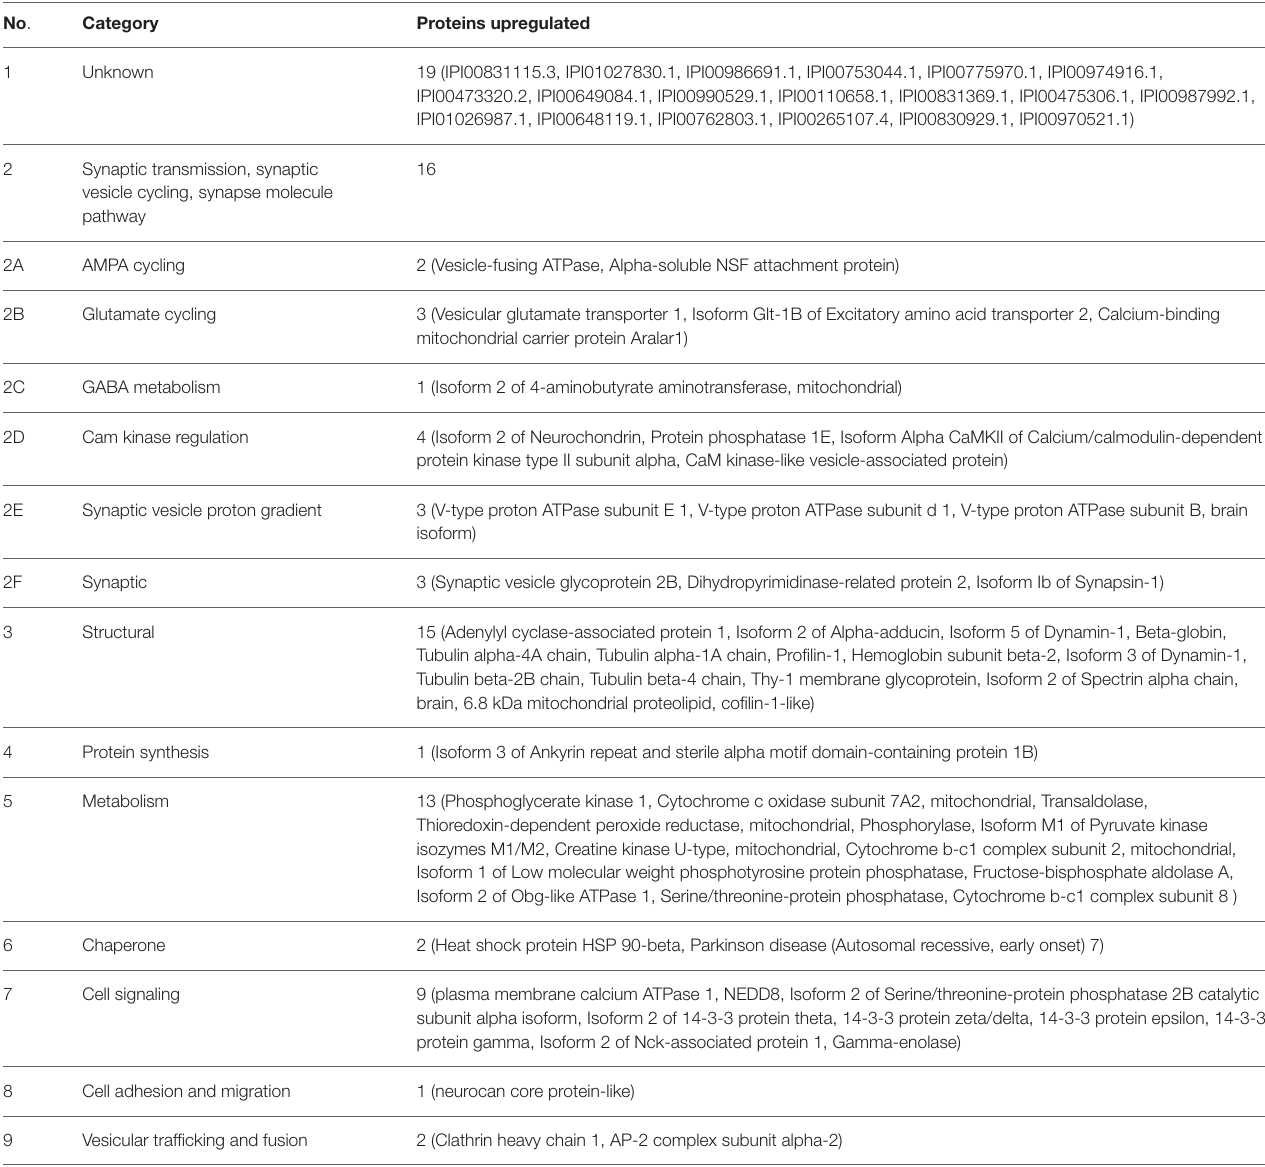
TABLE 2 | Proteins found up-regulated ( > 1.5 folds) in the hippocampus of Wdr13 − / 0 mice as compared to wild-type mice (78 out of 170 quantified). No .